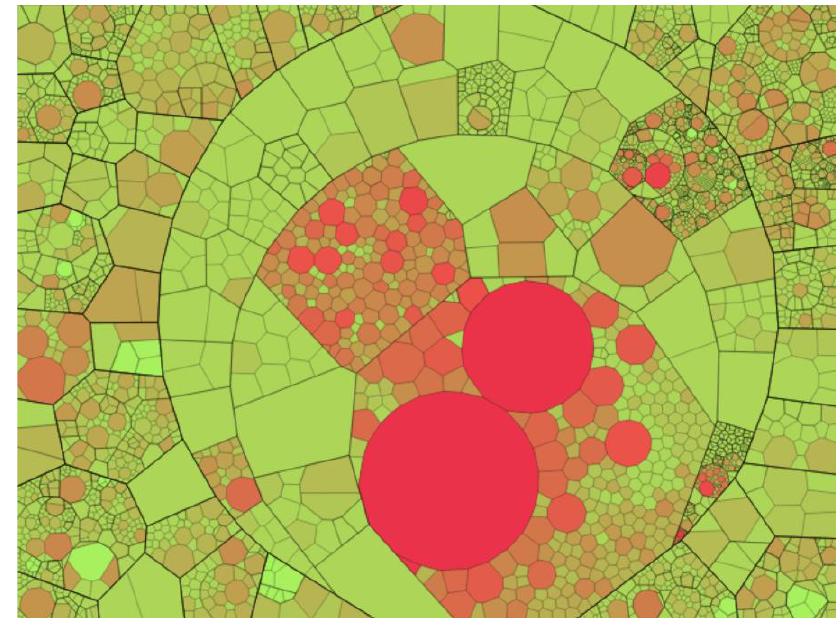
Figure 8. Hierarchical structure in the form of a Voronoi treemap [44].